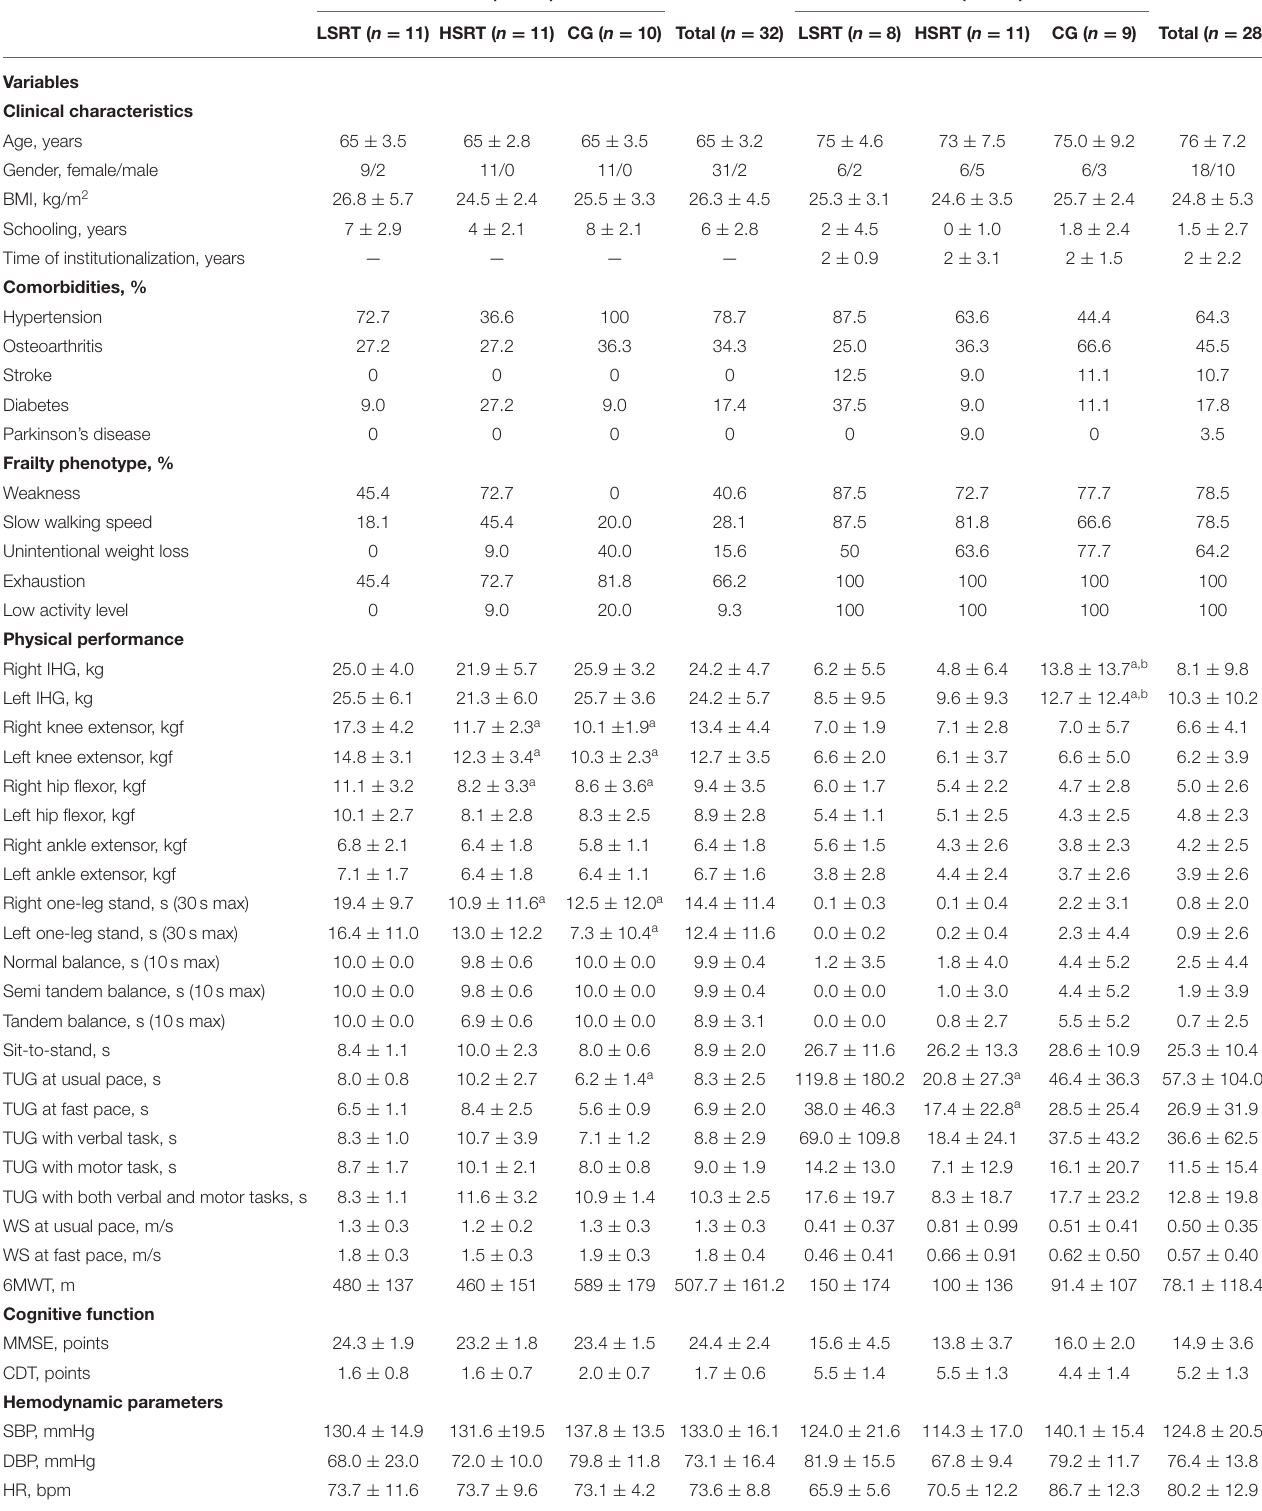
TABLE 1 | Main characteristics of study participants. Prefrail ( n = 32) Frail ( n =